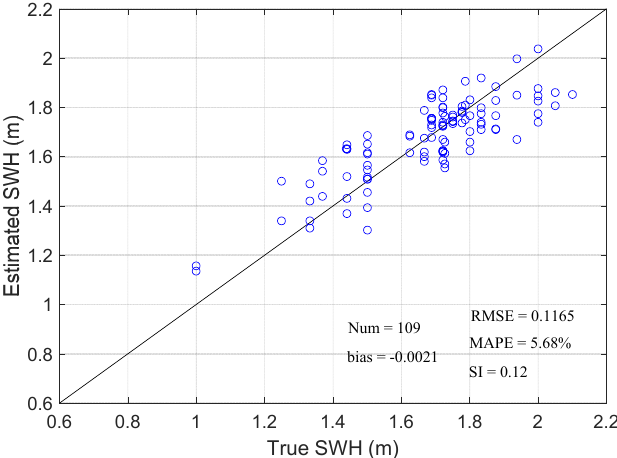
Figure 10. GNSS-R-retrieved SWH versus true SWH.